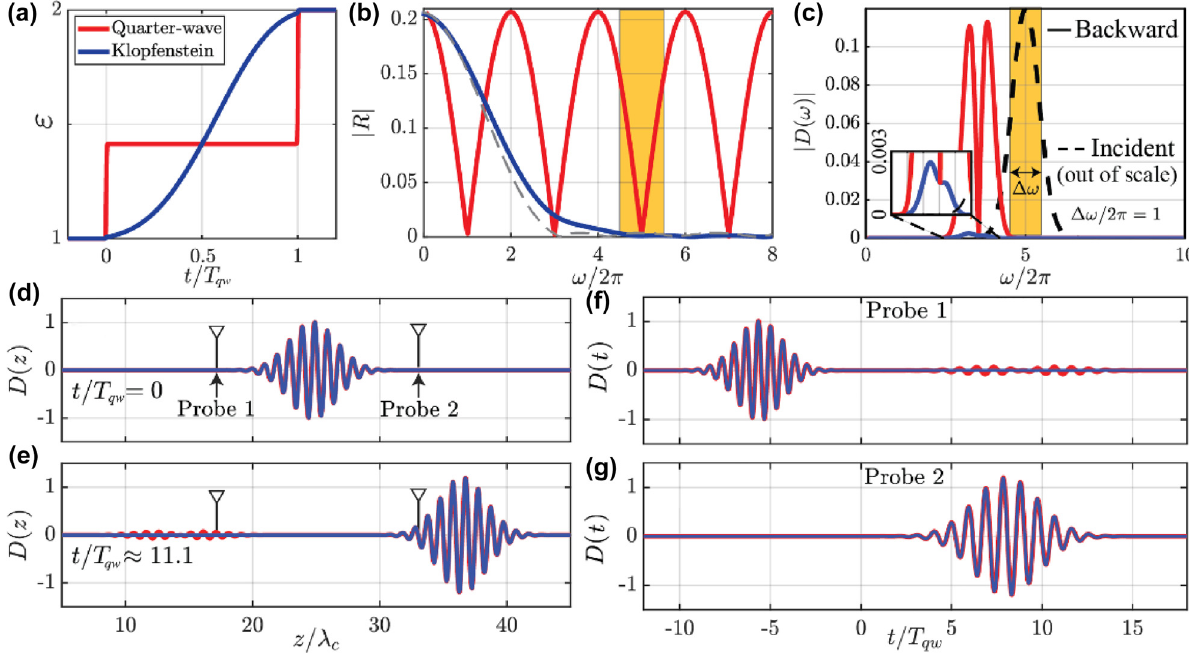
Figure 3: Comparison between temporal Klopfenstein taper and temporal antireflection coating. (a) Temporal permittivity profiles for a = 3, resulting in maximum ripples of amplitude temporal quarter-wave filter (red) and a Klopfenstein taper with cutoff A ∕ 2 𝜋 T qw R max ≈ 0.0014 (blue) and (b) their respective frequency response | R ( 𝜔 ) | , showing the broadband response of the Klopfenstein taper, whose = 3 is characterized by ripples of constant amplitude. The dashed grey line indicates the isorefractive result pass-band 𝜔 ∕ 2 𝜋 ≳ A ∕ 2 𝜋 T qw corresponding to the same impedance mismatch, for which case the response has an exact zero at the pass-band edge. (c) Normalized Fourier transform of the incident (dashed) and backward-scattered (continuous) parts of a broadband pulse with carrier frequency 𝜔 ∕ 2 𝜋 = 5 and full width at half-maximum Δ 𝜔 ∕ 2 𝜋 = 1 (shaded yellow region) for the switching cases: note how the Klopfenstein taper c (blue) generates virtually no backward wave (as quantified in the blow-up inset), whereas the quarter-wave layer cannot prevent the = 0 and sidebands of the pulse from being time-reversed. (d, e) Spatial distribution of the displacement field of the pulse at times (d) t ∕ T qw ≈ 11.1. (f, e) Temporal pulse profile at the locations of (f) probe 1 and (g) probe 2 shown in panel (e) t ∕ T qw